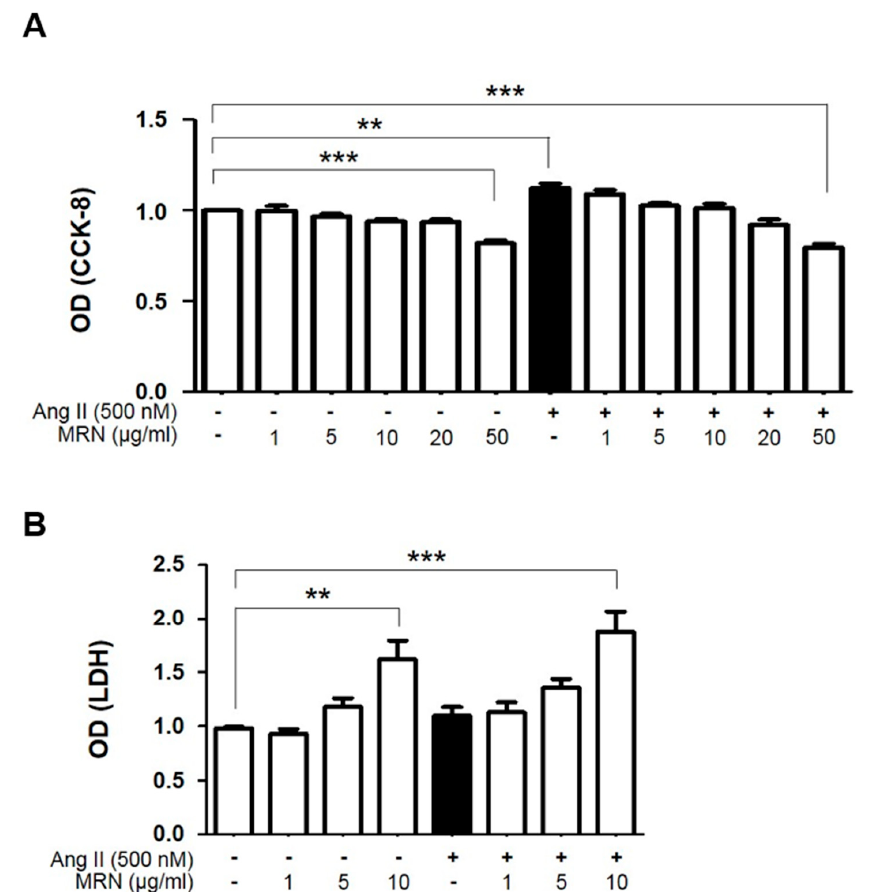
Figure 1. E ff ects of Nelumbo nucifera receptaculum extract on H9c2 cell viability. ( A ) Cell viability was measured by using the Cell Counting Kit-8 (CCK-8) assay, and ( B ) cytotoxicity was measured using the LDH assay. Cell viability (CCK-8) and cytotoxicity (LDH) were measured after treatment with 1–50 µ g / mL MeOH extract of receptaculum Nelumbinis (MRN) for 48 h in the presence or absence of angiotensin II (Ang II). Quantitative data were expressed as the mean ± SEM. of 3 independent experiments. ** p < 0.01, *** p < 0.001.